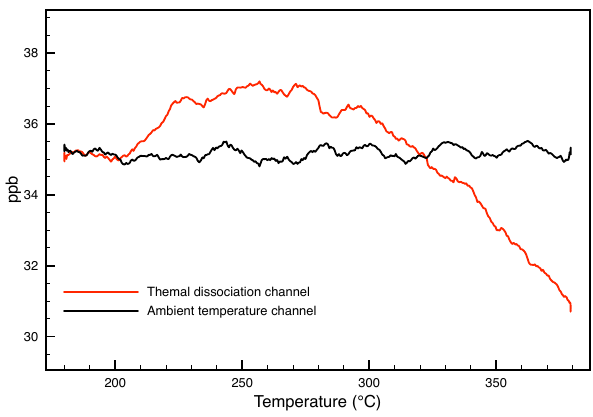
Figure A1. Laser-induced fluorescence signal from samples con- taining ∼ 35ppb NO 2 and 2ppb 2-ethylhexyl nitrate passing through the unheated channel (ambient temperature, black trace) and thermal dissociation channel (red trace) in the presence of O 3